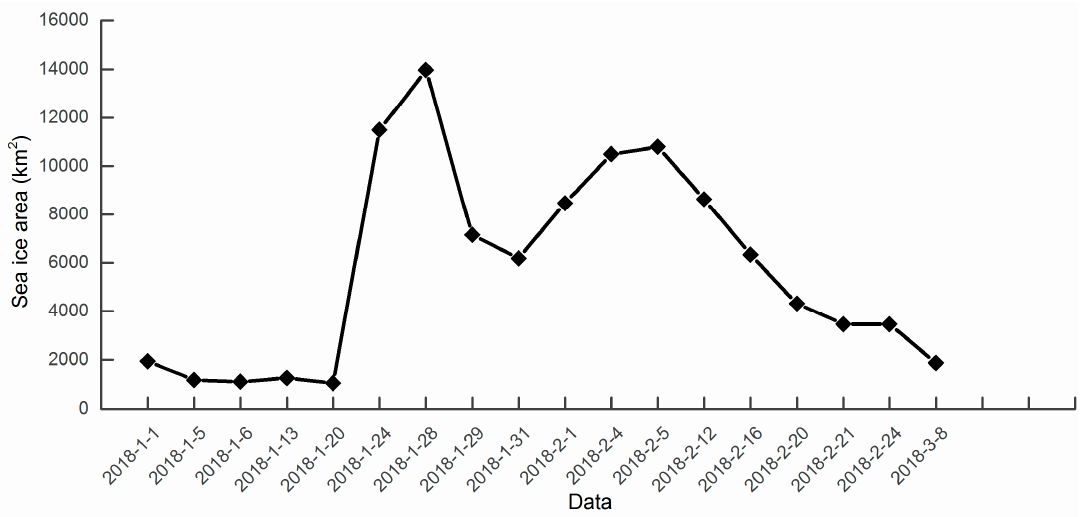
Figure 9. The evolution of the Bohai Sea ice area extracted from OLCI images during the winter of 2017 – 2018.